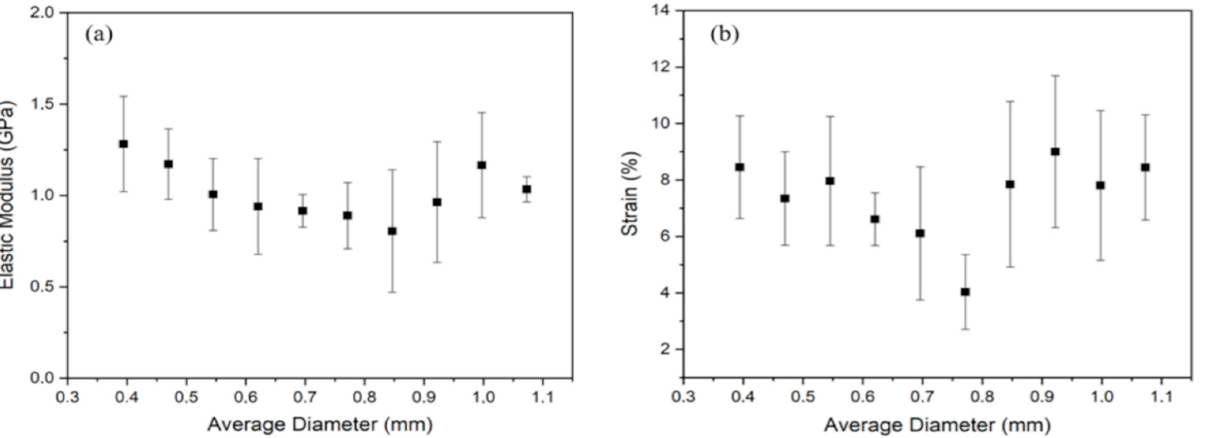
Figure 8. ( a ) Elastic modulus; ( b ) strain of TVFs.